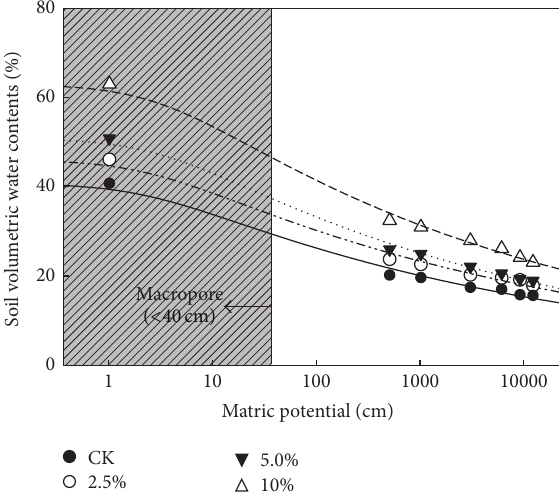
Figure 3: Water retention curves for the mudstones amended with rice hull biochars (RHB-400) after 168d of